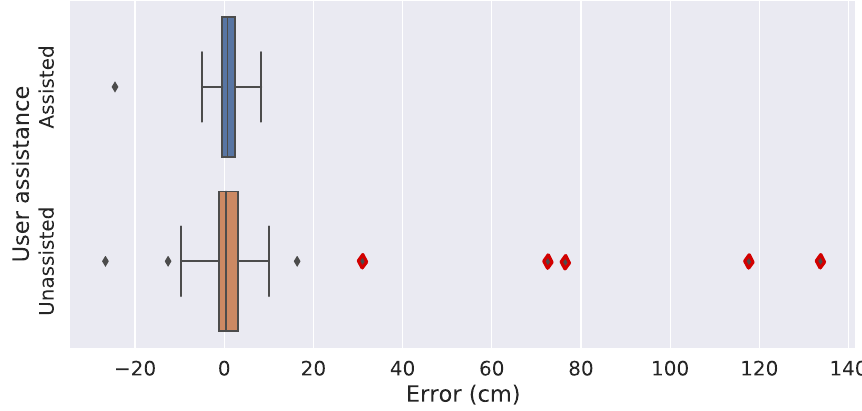
Figure 3. User assistance improves the trunk detection rate to 100% in the Beechwoods and Van Cortlandt data sets. The box lines show the 25th, 50th, and 75th percentiles of the measurement error distribution. The plot whiskers show two times the interquartile range, and outliers are data points outside of this range. Outliers highlighted in red are those in which the algorithm failed to detect the trunk: at least one of the identified boundary lines does not correspond to the trunk in any way.